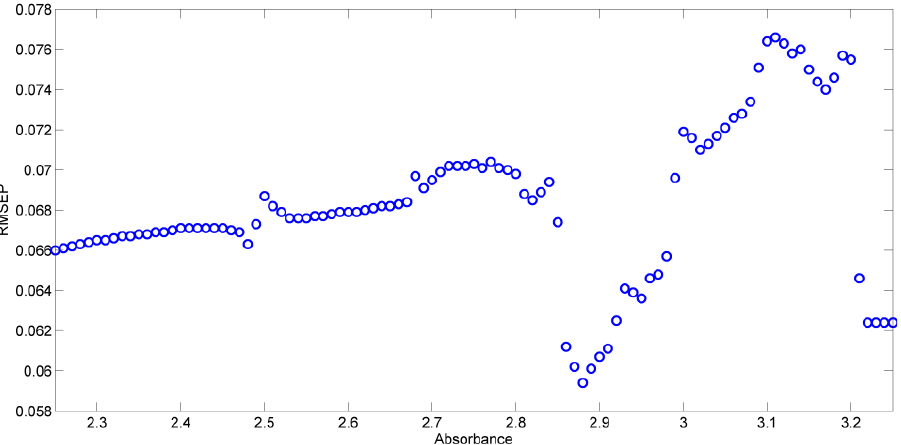
Fig. 5. The results of RMSEP values with di®erent high absorbance